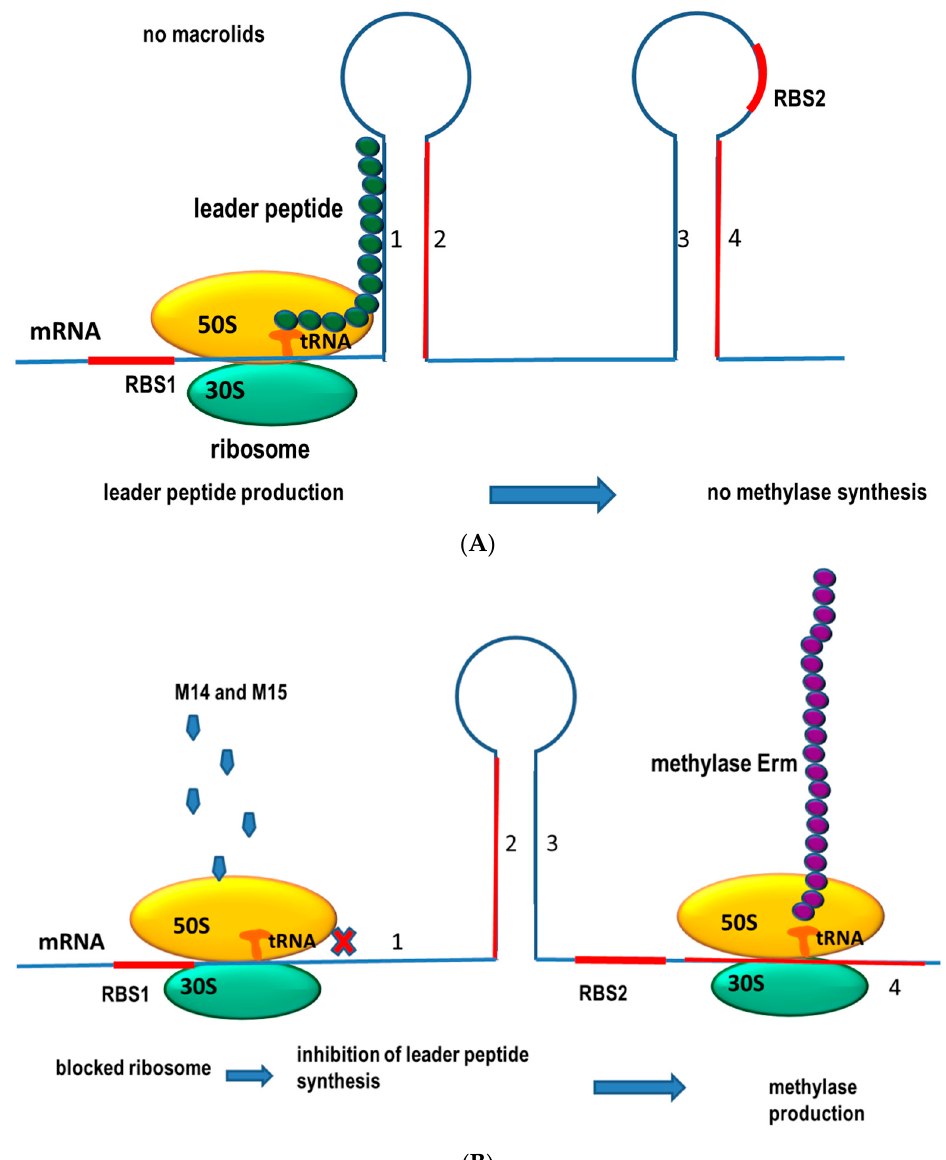
Figure 4. Erm methylase production by S. aureus is regulated at the translational level. RBS—ribosome binding site, M14 and M15—macrolides with a 14- and 15-member ring. ( A ) In the absence of M14 and M15 macrolides, a leader peptide is produced that attaches to the mRNA preventing translation of the methylase Erm ( A , B ). When the bacterial ribosome is blocked by macrolides, the leader peptide is not translated and the RNA conformation changes in such a way that methylase poduction is